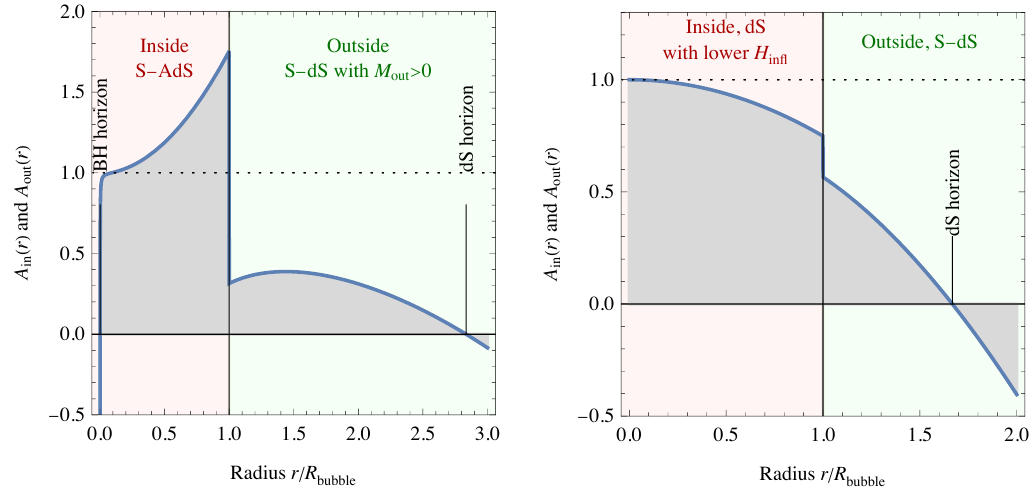
Figure 2 . Left : typical form of A ( r ) in the thin-wall approximation for the AdS bubble inside dS considered in [2]. The discontinuity is proportional to the wall tension σ . Here σ is assumed to be large enough for M 0 . Right : typical form of the initial condition assumed in [1] and in the out > present paper. Smaller values of A loosely mean that time runs more